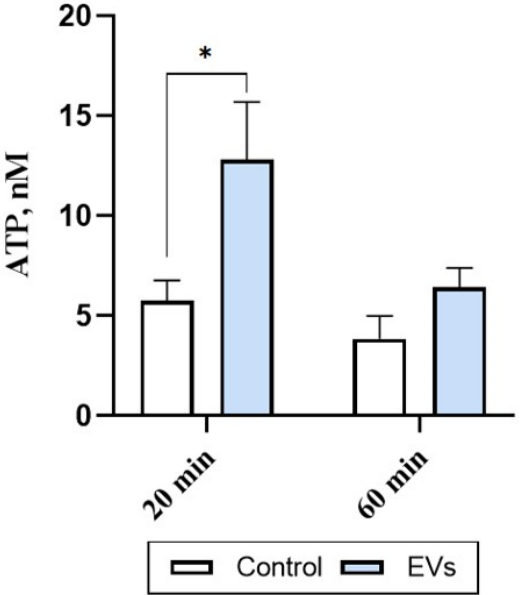
Figure 3. EVs trigger ATP release from human microglial cells. Microglial cells were exposed to EVs (1 AU/well) diluted in BS for 20 and 60 min. Supernatants from each well were subjected to ATP assay. ATP was measured using ATPlite Luminescence Assay System with a Perkin Elmer Wallac 1420 Victor2 instrument using Wallac 1420 software. Each bar represents mean ± SEM, statistically significant difference was determined by two-way ANOVA, Sidak’s multiple comparisons test, * p < 0.05 ( n = 15–20 wells from 3 experiments).